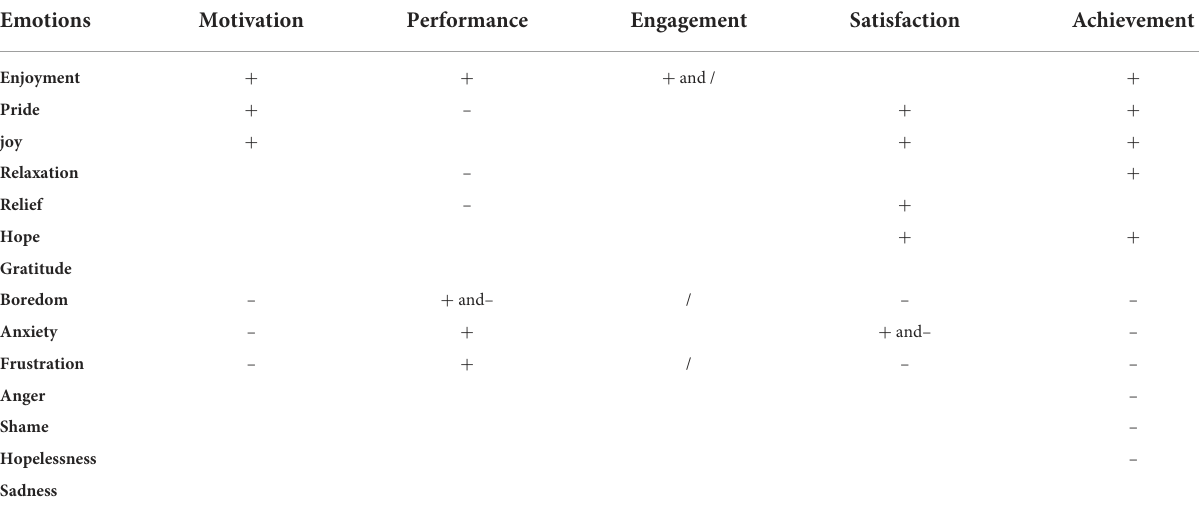
Online learning